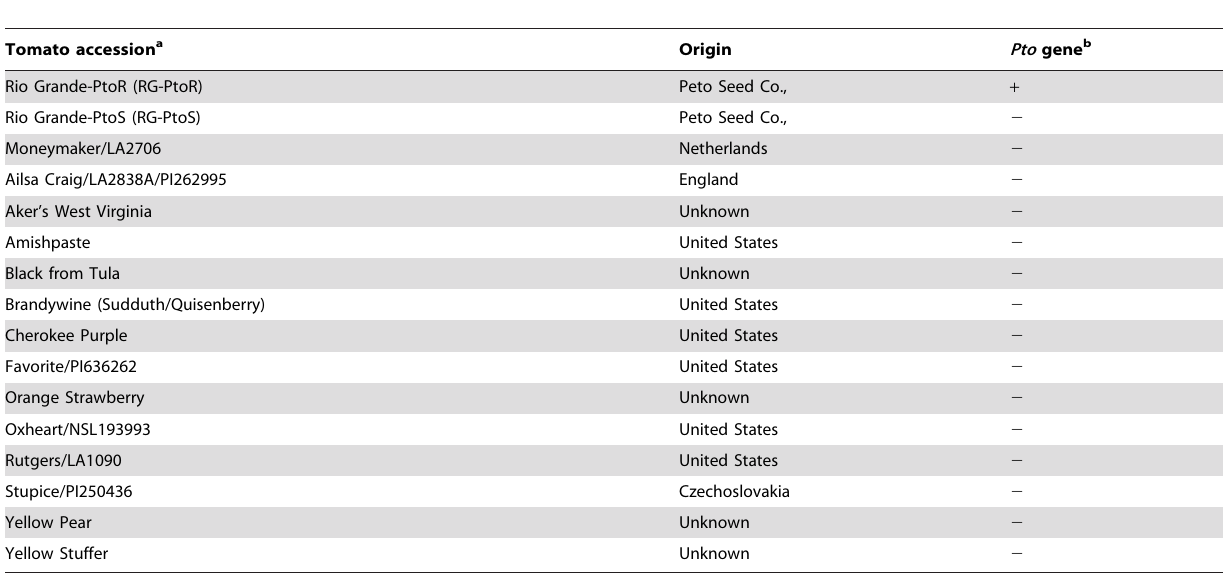
Table 1. Tomato heirloom varieties used to screen for MAMP responsiveness and resistance to bacterial speck caused by NC-C3, a Pseudomonas syringae pv. tomato race 0